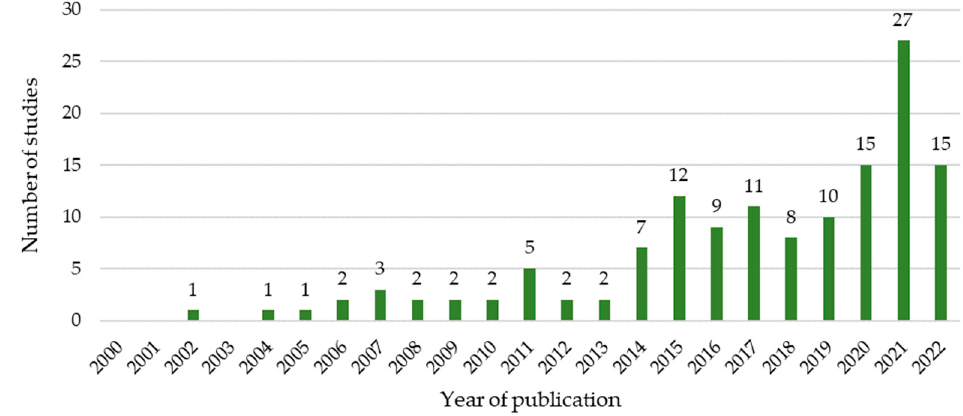
Figure 1. Number of documents according to the publication year.